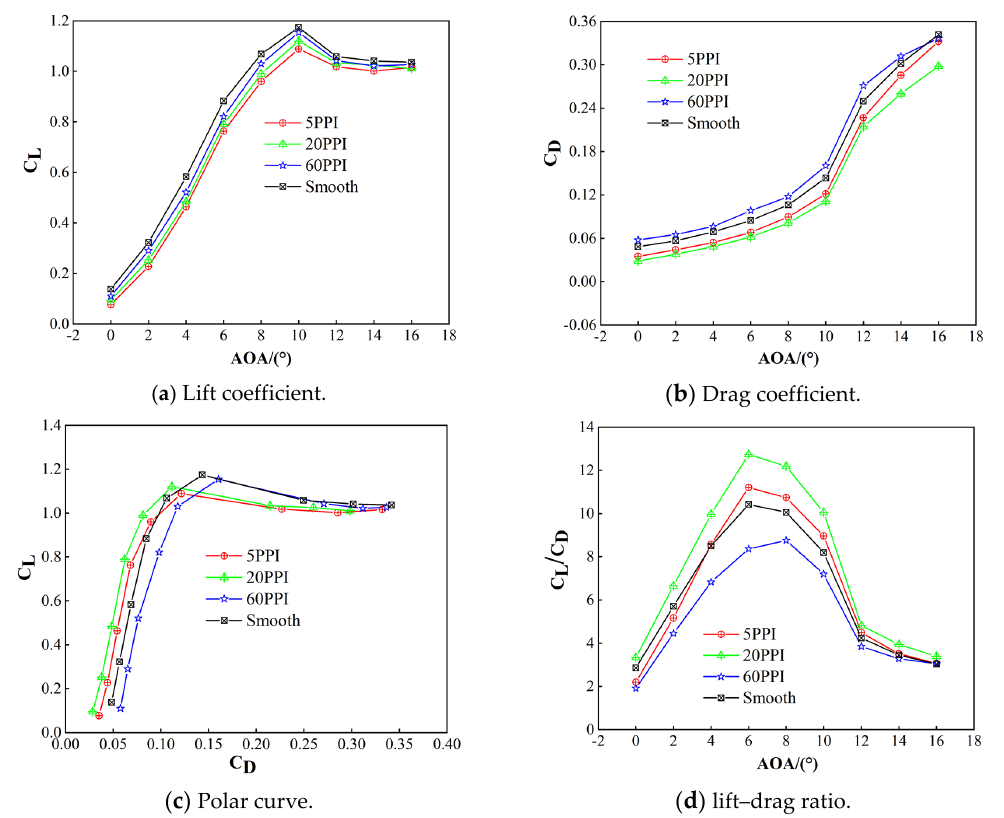
Figure 5. Aerodynamic comparison of airfoil–laying porous media of different pore densities.